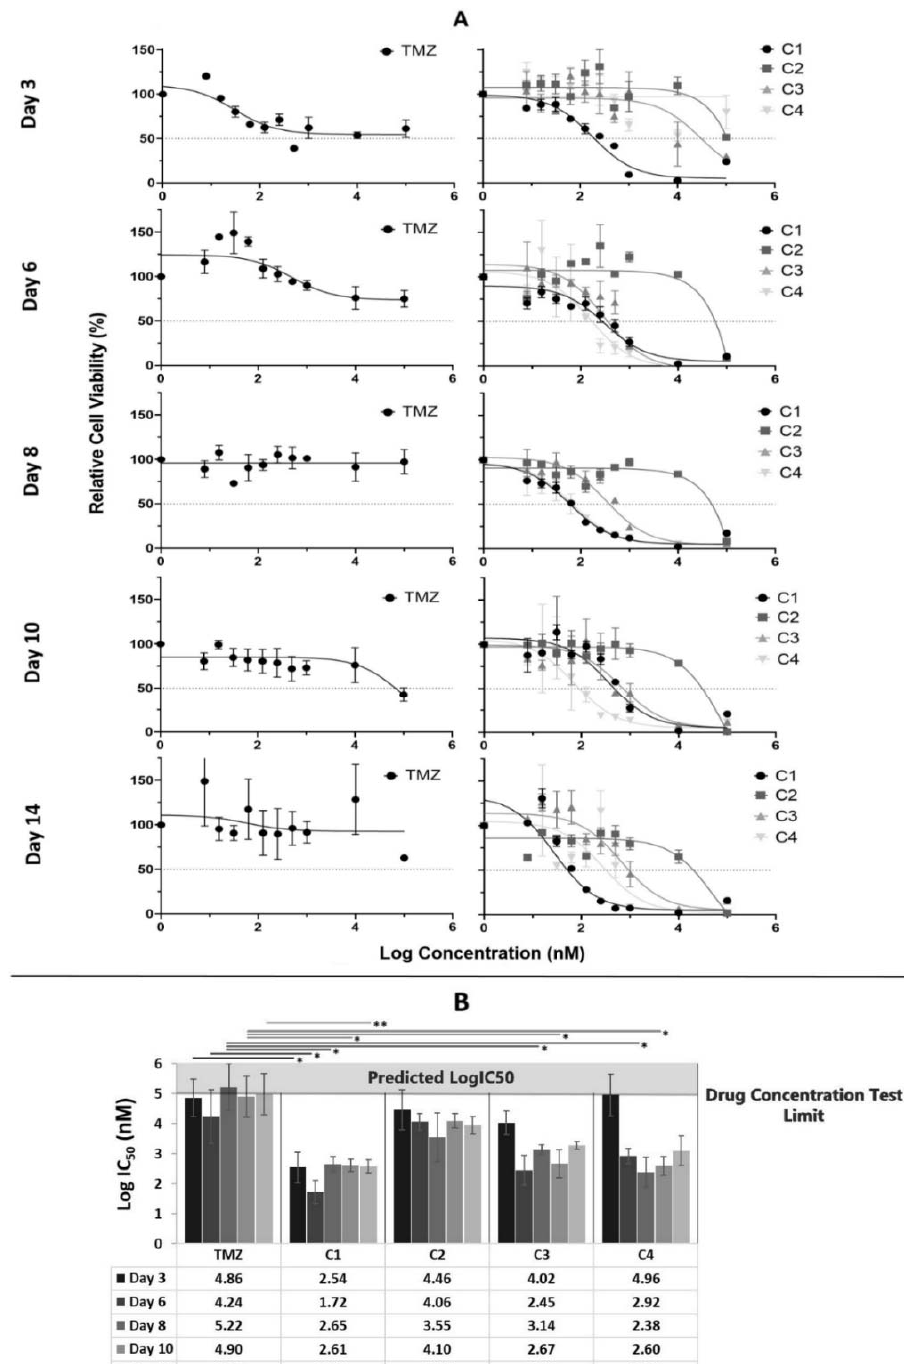
Figure 2. Days 3, 6, 8, 10 and 14 of incubation drug cytotoxicity data for TMZ and each drug combi ‐ nations tested against patient ‐ derived tumour margin samples using MTT assay. ( A ) Average ( n